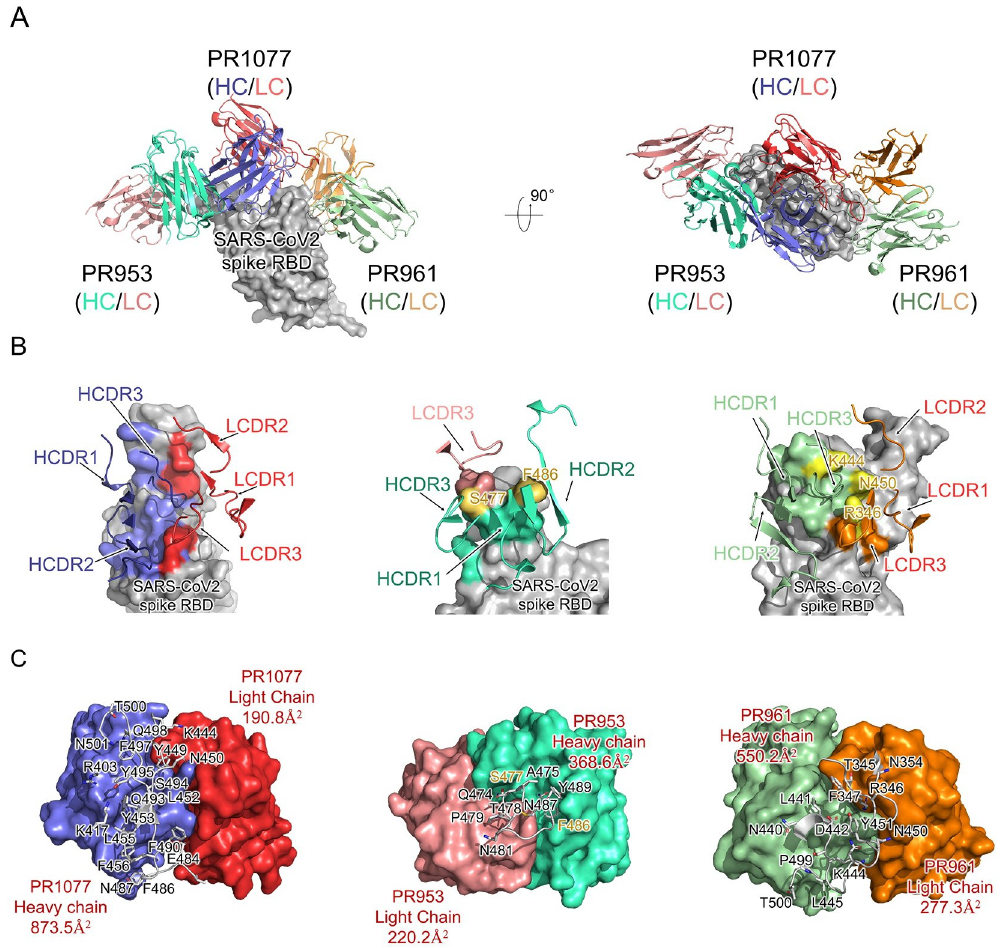
Fig 3. Structural analysis of the SARS-CoV-2 RBD-NAbs scFv complex. (A) Overall structures of the PR1077, PR953, and PR961-Fab-RBD complexes. The PR1077 HC (colored slate blue) and light chain (colored red) are shown. PR953 heavy (colored green cyan) and light (colored salmon red) chains and PR961 heavy (colored pale green) and light (colored orange) chains are displayed. The SARS-CoV-2 RBD is colored in gray and displayed in surface representation. (B) The epitopes of antibodies are shown in surface representation. The CDR loops of NAbs are colored as above. The S477 and F486 residues in contact with both the heavy and light chains of PR953 are colored in yellow; 3 hydrogen donor residues (R346, K444, and N450) which contact with both the heavy and light chains of PR961 are colored in yellow. (C) The binding surface of NAbs with SARS-CoV-2-RBD. The interaction residues of RBD are shown in sticks and labeled accordingly; variable regions’ interaction surfaces of NAbs are colored as above. HC, heavy chain; HCDR, heavy chain complementarity-determining region; LCDR, light chain complementary-determining region; NAb, neutralizing antibody; RBD, receptor-binding domain; SARS-CoV-2, Severe Acute Respiratory Syndrome Coronavirus 2; scFv, single-chain variable fragment.